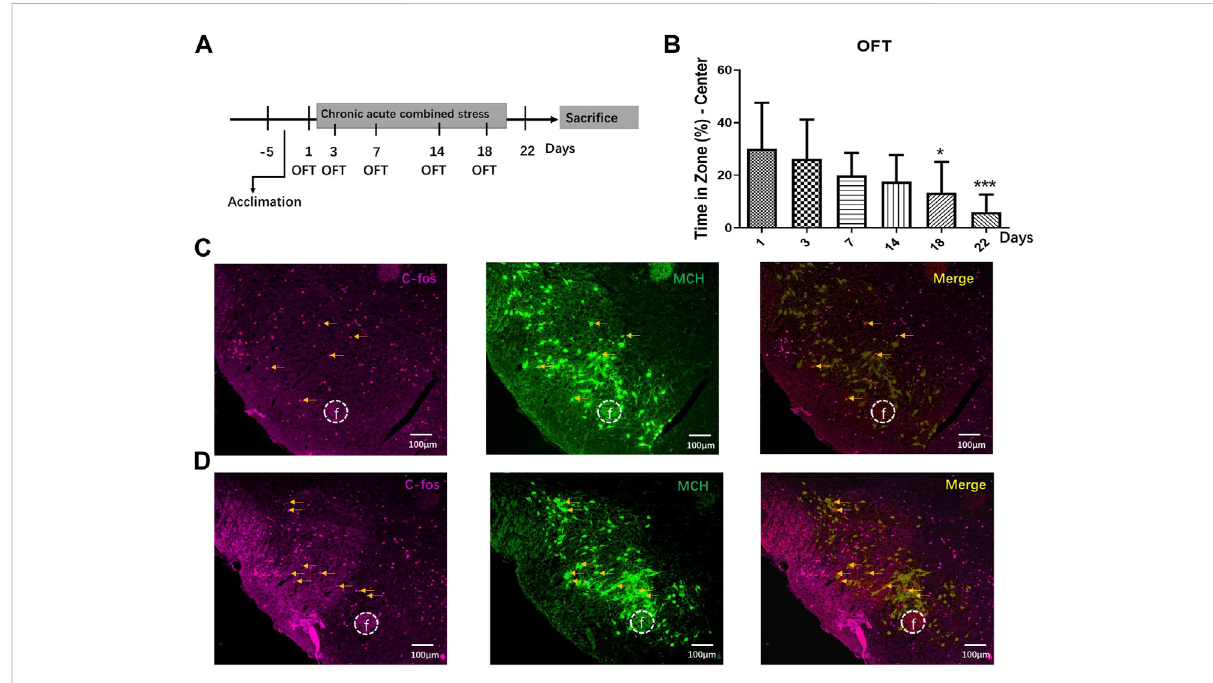
FIGURE 4 CACS induced anxiety-like behaviors and activated MCH neurons in the mice. (A) The timeline of Experiment 4. (B) Changes in stay time at the OFT center on days 1, 3, 7, 14, 18, and 22 during CACS modeling and CACS mice showed anxiety-like behaviors ( n = 10). (C) A representative photograph of MCH/C-FOS fl uorescence immunohistochemistry in the LHA of the control group and neurons co-expressed with MCH/C-FOS, indicating thenumberofMCH neuronsactivated ( n =6). (D) Representative fl uorescence immunohistochemistry photographs ofMCH/C-FOS in the LHA of the CACS model mice ( n =